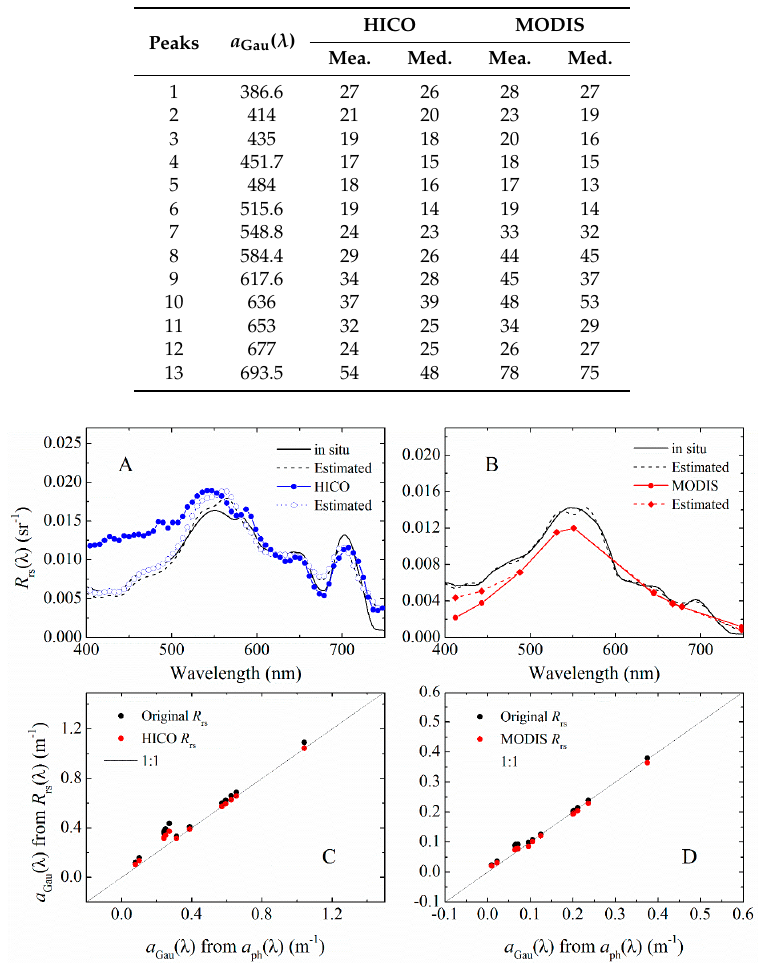
Figure 9. ( A ) Example spectra of in situ and HICO measured ( R rs ( λ )), and their corresponding estimated spectra from MuPI; ( B ) example spectra of in situ and MODIS measured ( R rs ( λ )), and their corresponding estimated spectra from MuPI; and ( C , D ) the 13 a Gau ( λ ) derived from in situ, HICO and MODIS R rs ( λ ) were plotting against the a Gau ( λ ) from decomposition of in situ measured a ph ( λ ). Table 7. The mean (Mea.) and median (Med.) of unbiased absolute percentage differences of a Gau ( λ ) estimated from R rs ( λ ) of HICO and MODIS satellite imagery.